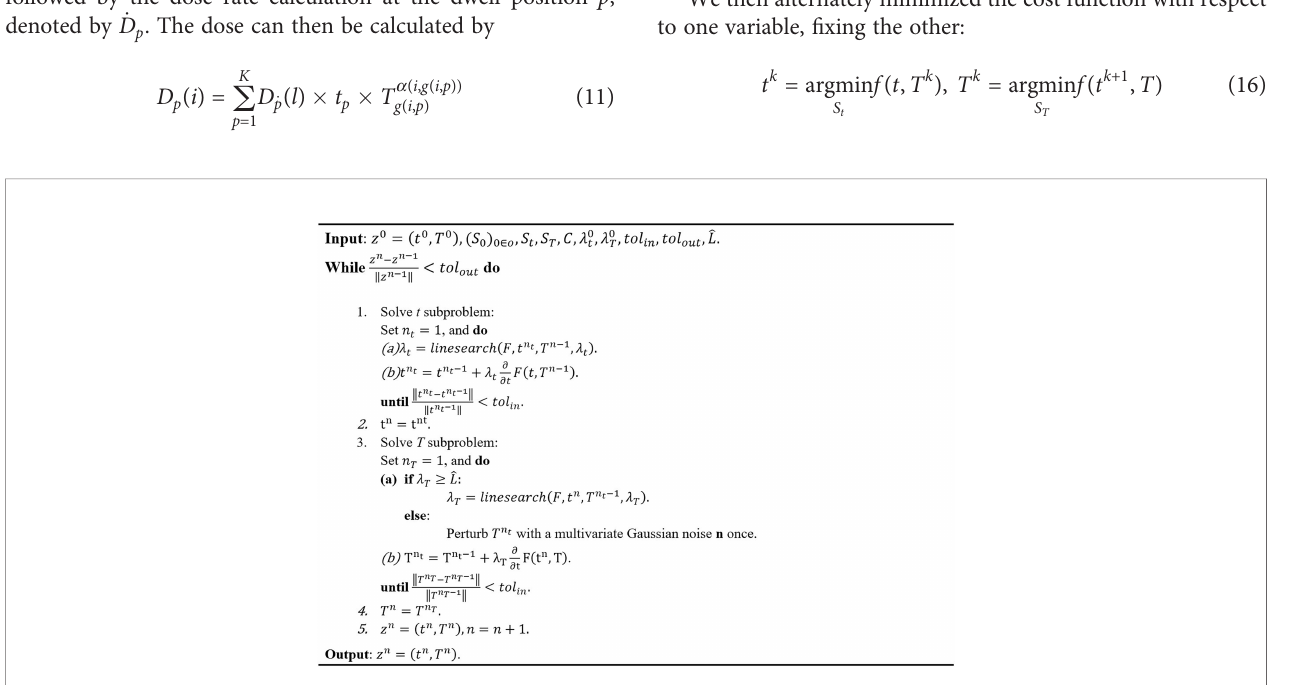
FIGURE 3 | Alternating minimization algorithm for Equation